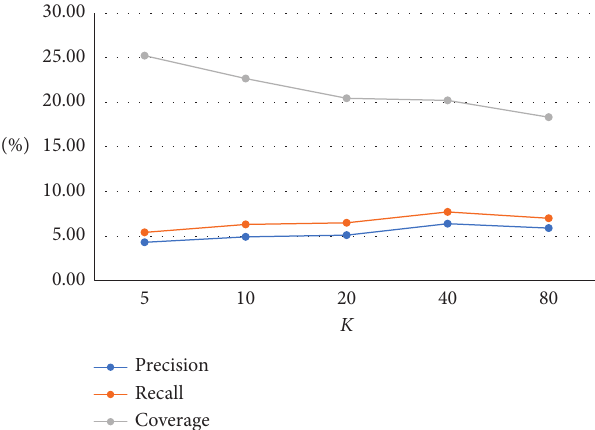
Figure 7: Based on the Jaccard coefficient, user similarity calculation is performed under multiple K